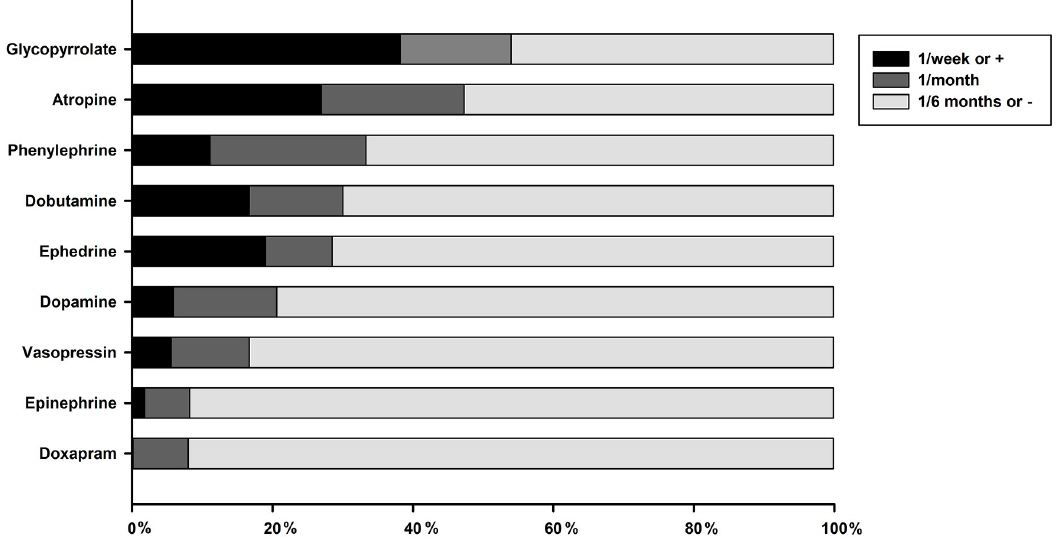
Fig 1. Cumulative percentage of respondents reporting their frequency of use for each emergency drug in small animals anaesthesia. Frequency of use is color-coded for at least 1/week, 1/month and 1/6 months or less.